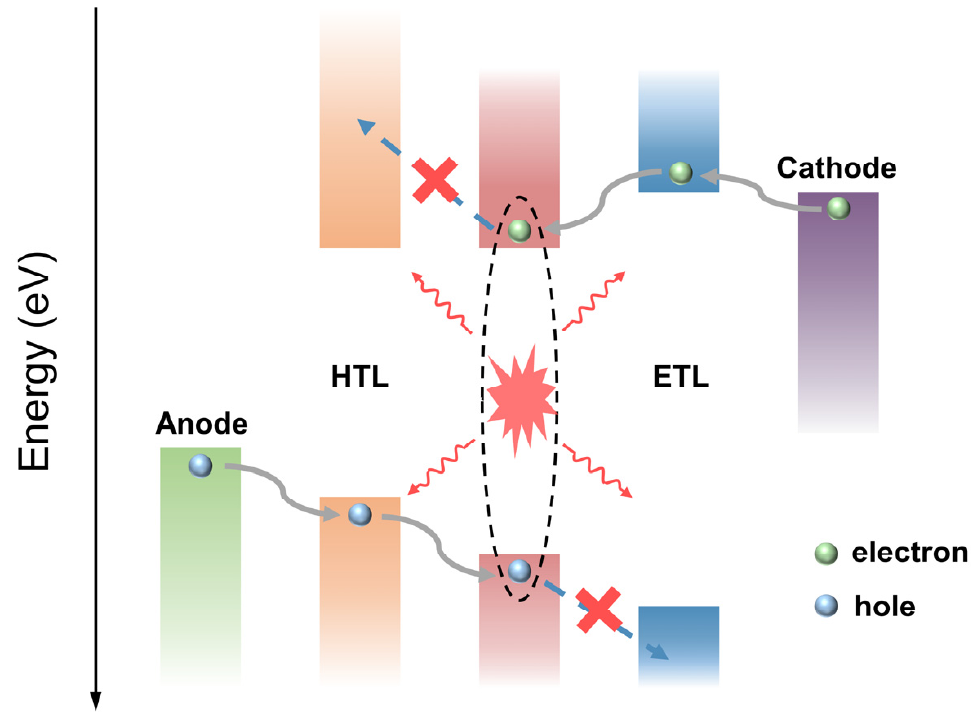
Figure 6. The general energy level and light-emitting mechanism diagram of MNC-based electroluminescent LEDs.